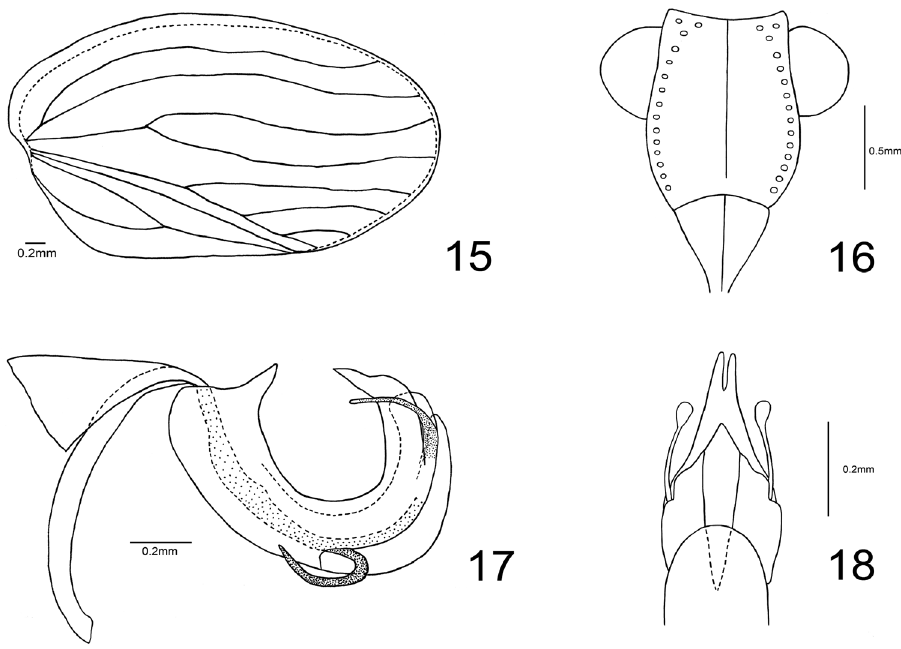
Figures 15–18. Sinonissus brunetus sp. n. 15 Forewing 16 Frons 17 Phallic complex, lateral view 18 Apex of phallic complex, ventral view.